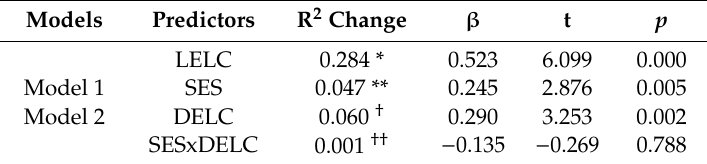
Table 5. Results of the hierarchical regression analyses on semantic access (speeded nam.). R 2 = 0.06. Models